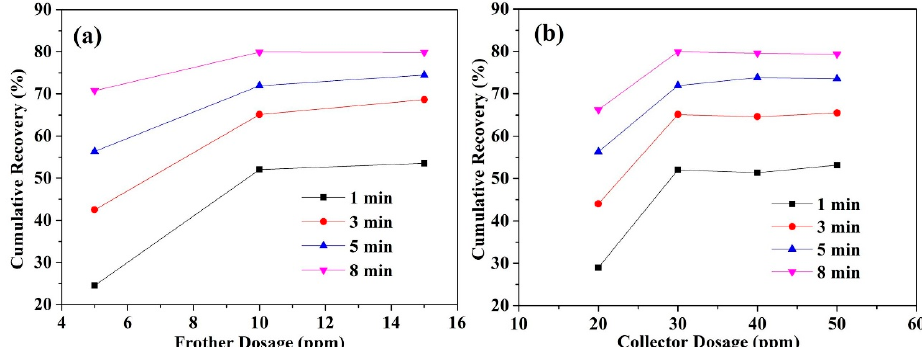
Figure 1. The effects of ( a ) frother and ( b ) collector on chalcopyrite recovery.